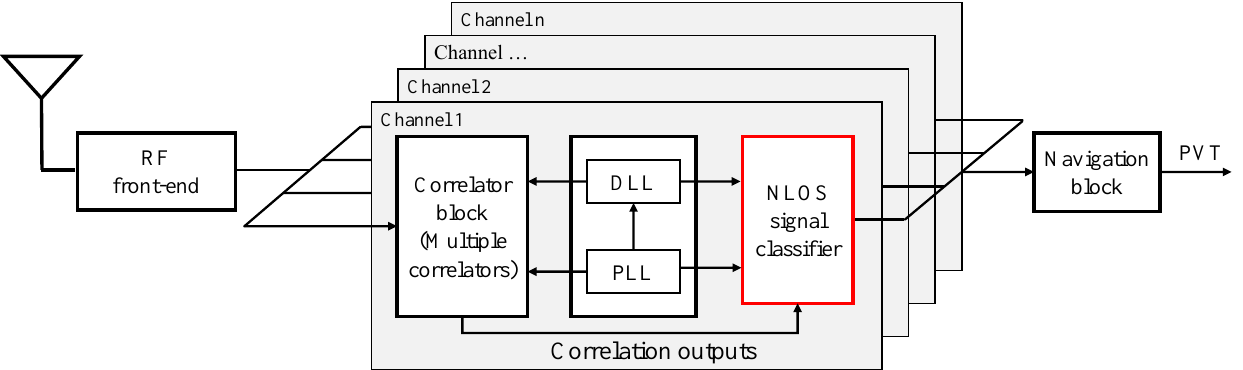
Figure 2. Outline of the proposed system. We incorporated an NLOS discriminator into the conventional GNSS signal processing algorithm, which directly discriminates the NLOS signal from the correlation output and functions as a filter that outputs only the LOS